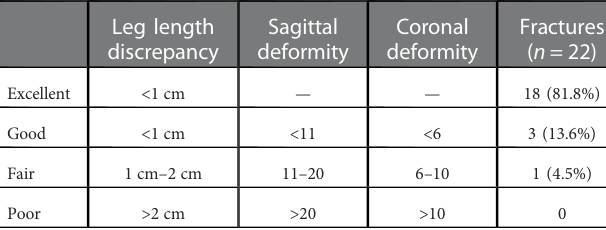
TABLE 2 Grading of radiologic results. Leg length